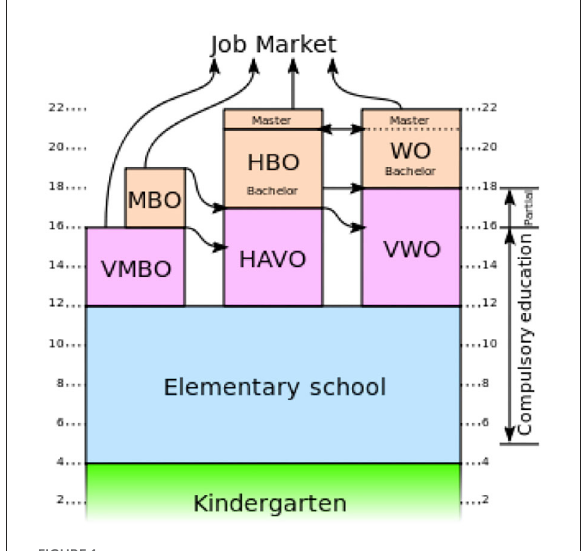
FIGURE1 Overview of the Dutch education system (Stam,